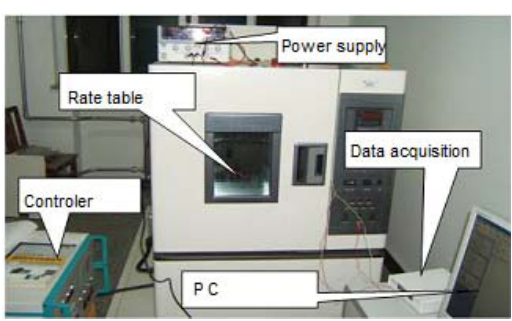
Figure 13. Testing system.